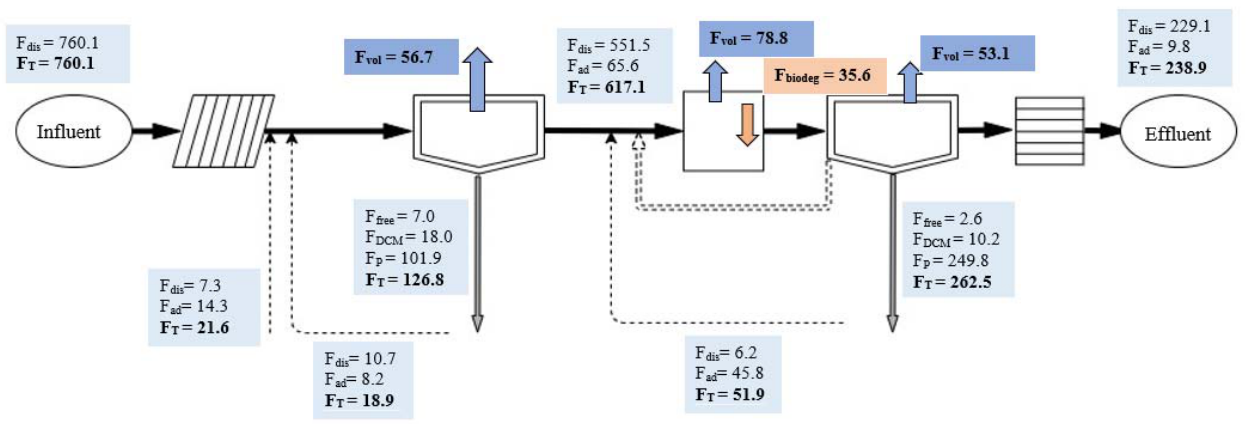
Figure 3. Fate of naphthalene in the water line. Results are presented in g/day. F dis is the resulting load in the dissolved phase, F ad is sorbed to particles in the water line, F free is freely dissolved, F DCM is sorbed to the dissolved and colloidal matter (DCM), and F p is sorbed to particles going to the sludge line.